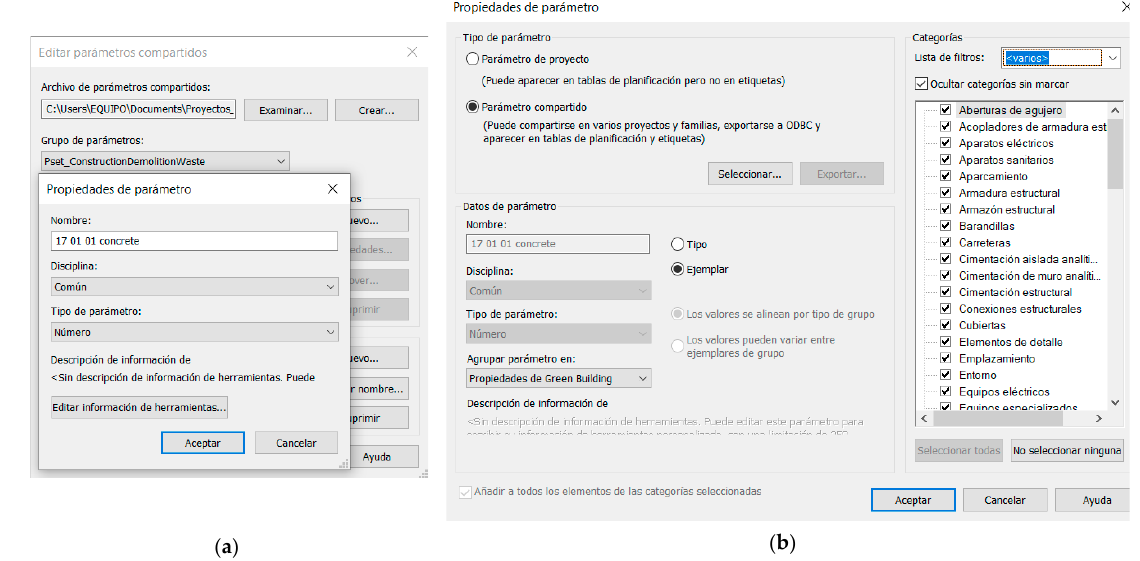
Figure 3. Panel for the definition of attributes and type of parameters in Revit: ( a ) Editing shared parameter panel; ( b ) Parameter property panel.